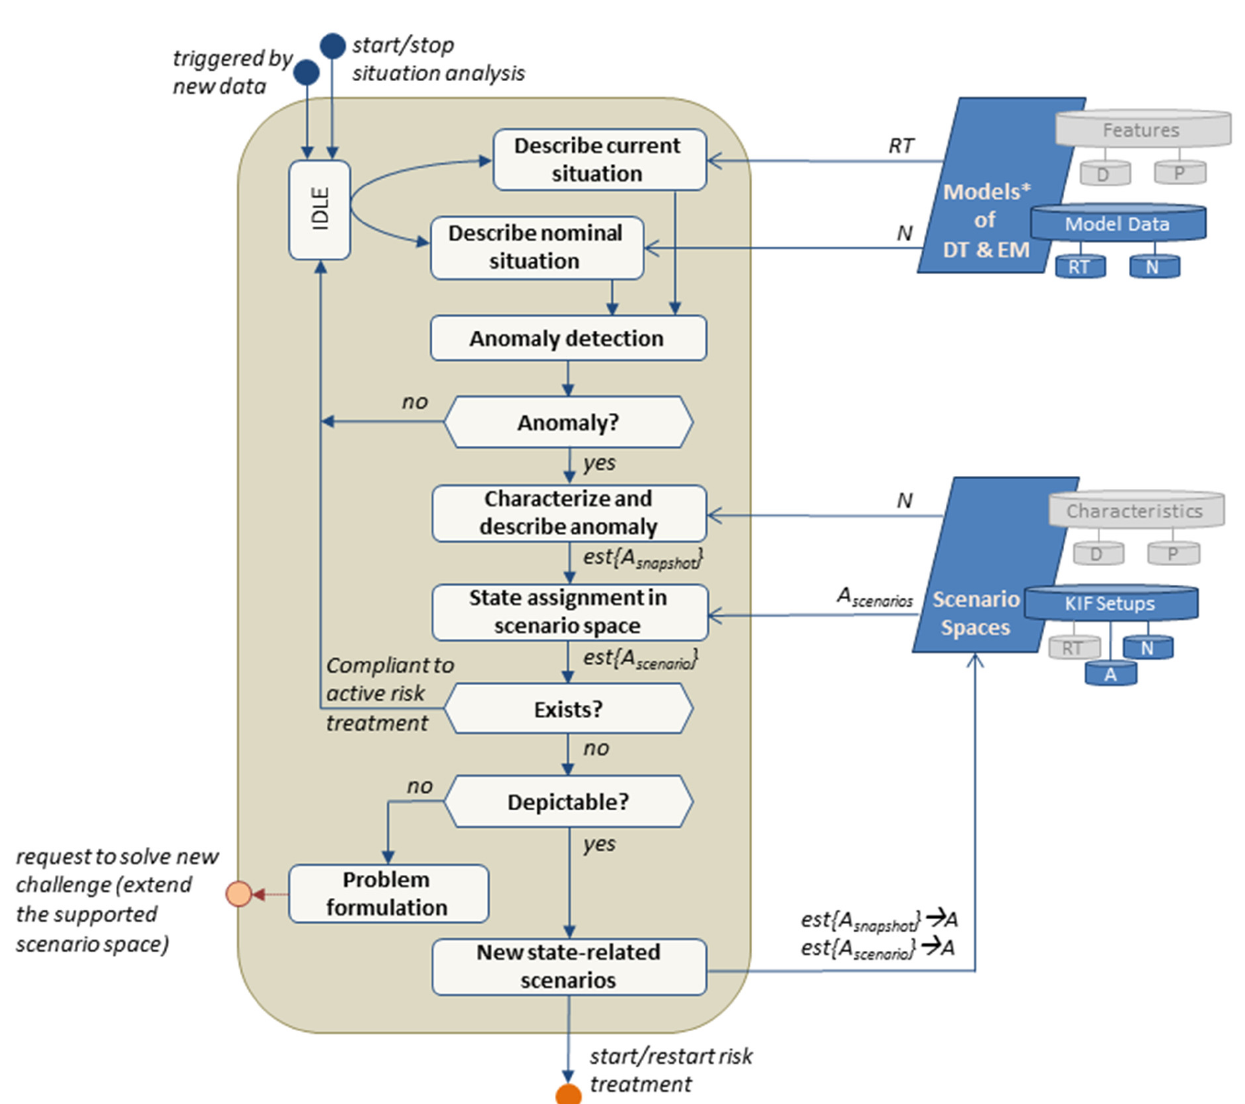
Figure 8. Flow chart of situation analysis.